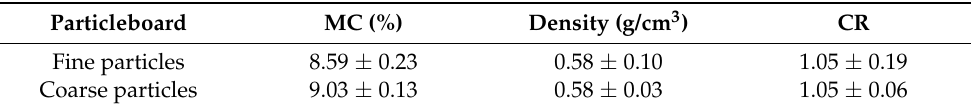
Table 2. Average values ( ± SD) of the physical properties of D. asper